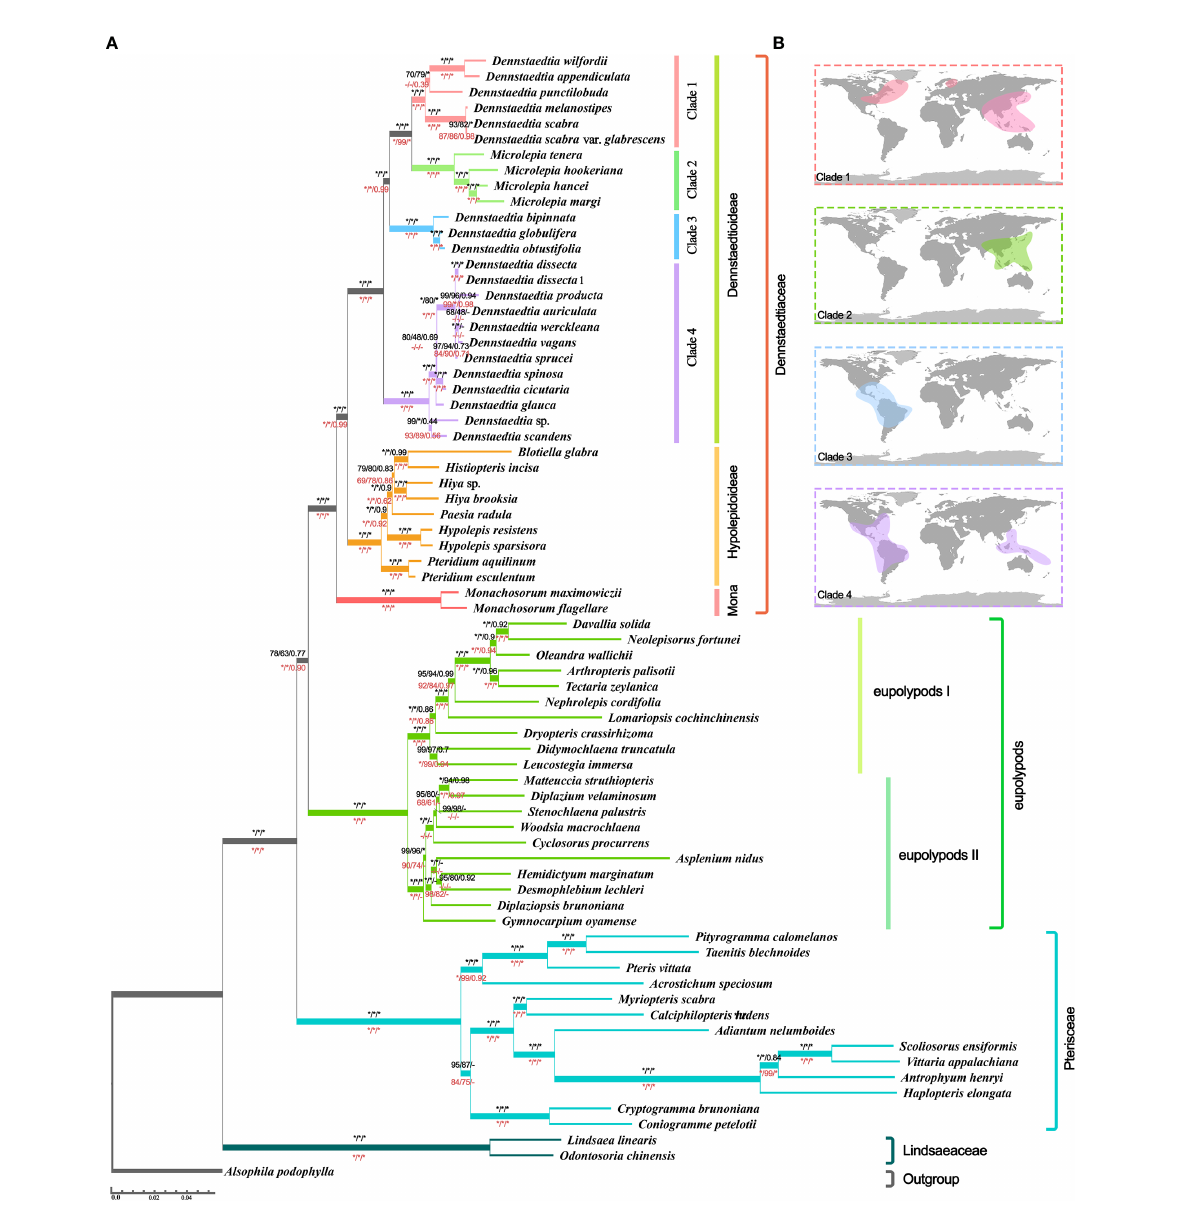
FIGURE 8 Species tree (A) Tree topology and branch lengths obtained from the IQ-TREE based on “ CDS-codon-align-rm3 ” matrix. Numbers at the nodes represented the ultrafast bootstrap (UFBoot) values of IQ-TREE, rapid bootstrap (RBS) values of RAxML, and local posterior probability (LPP) values of ASTRAL. The black values above the branches obtained from “ CDS-codon-align-rm3 ” matrices and red values below the branches obtained from amino acid matrices (Figure S2). Moreover, the asterisks (*) indicated 100% UFBoot/ RBS or 1.0 LPP, the hyphen (-) indicated support absent from the corresponding tree. (B) Global distribution of Dennstaedtioideae (Dennstaedtioid clade) species in clades1-4 obtained from the Global Biodiversity Information